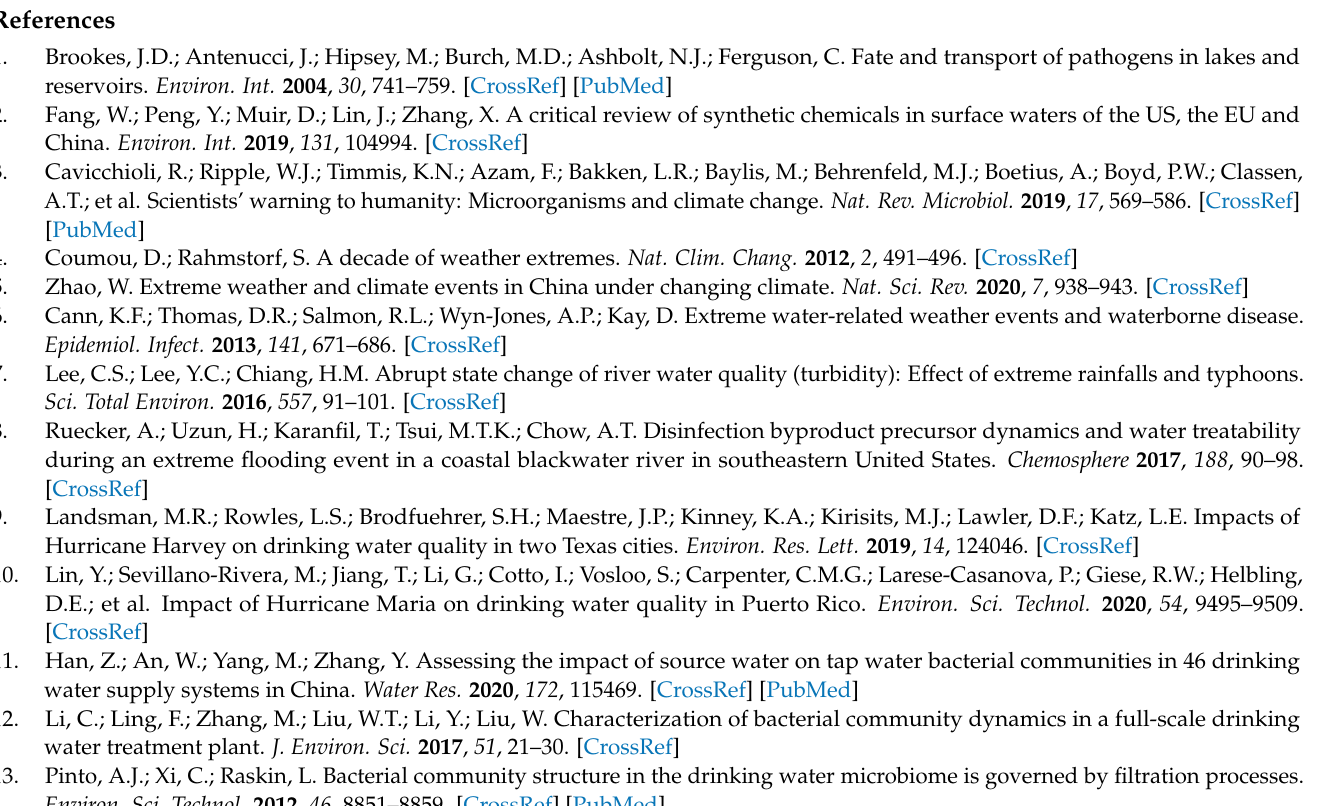
points. Table S1: Construction of major treatment facilities in the DWTP, Table S2: Physiochemical parameters of source water samples collected at different timepoints, Table S3: